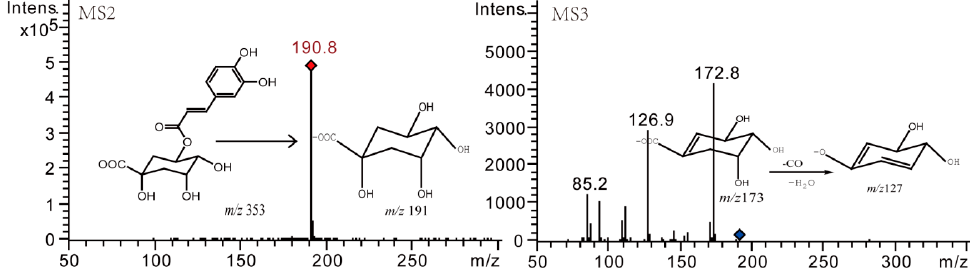
Figure 8. Negative MS n spectra and fragment ions of compound 1 .